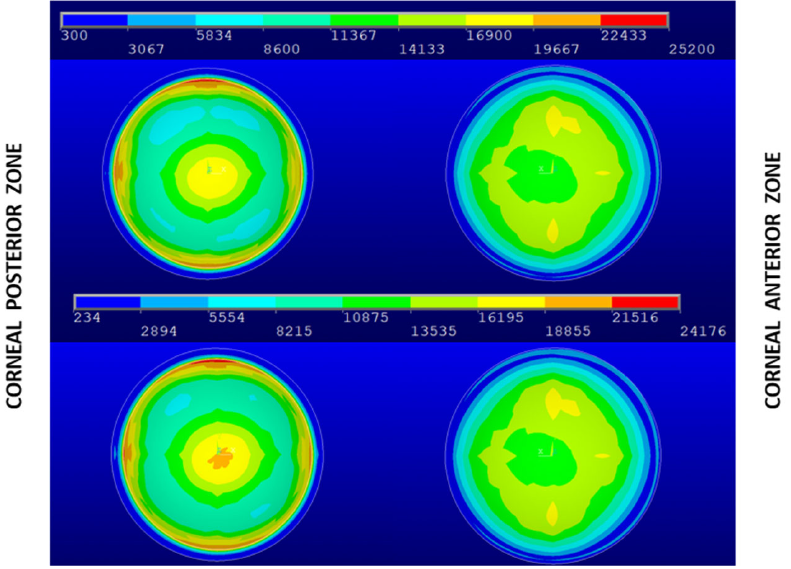
Figure 5. Stress distribution in measurement phase for cornea G0. Displacement method ( Upper ), prestress method ( Lower ).